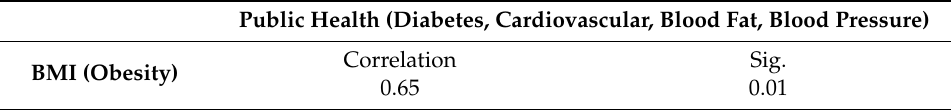
Table 10. Correlation coe ffi cients between obesity and public